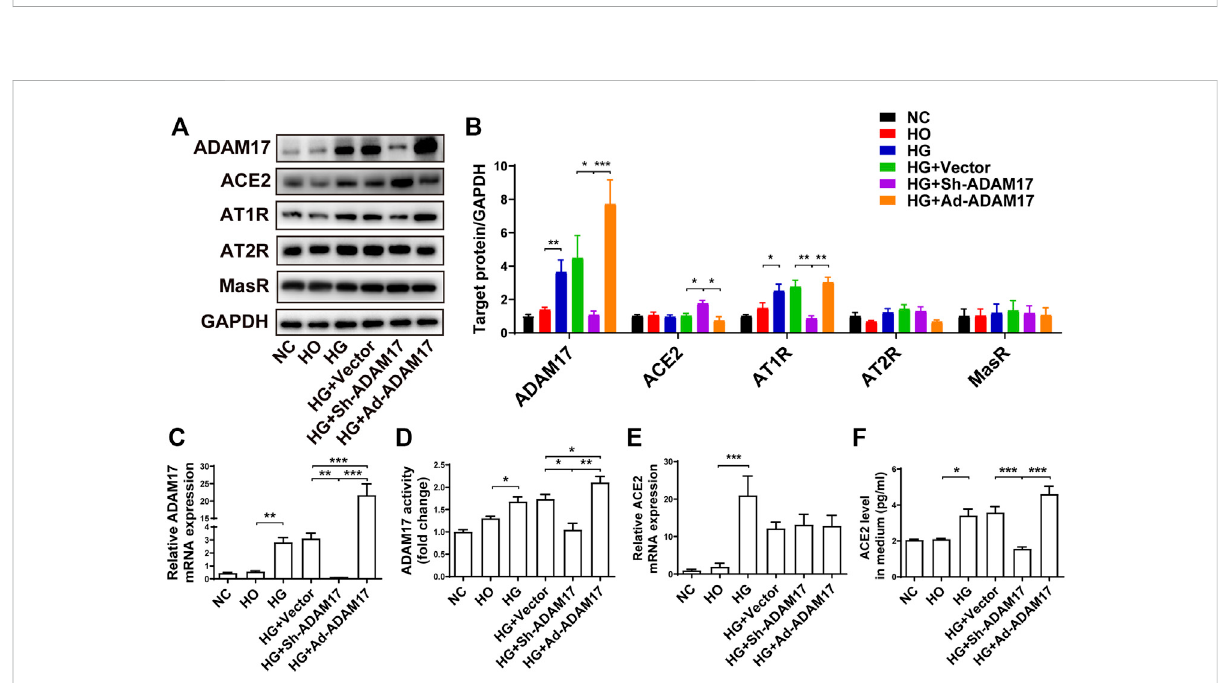
FIGURE 5 Comparison of ADAM17, ACE2, AT1R, AT2R and MasR expression in 6 groups of primary cardio fi broblasts. (A) Representative Western blot images of ADAM17, ACE2, AT1R, AT2R, and MasR in 6 groups of cardio fi broblasts. (B) Quanti fi cation of protein expression of ADAM17, ACE2, AT1R, AT2R, and MasR in 6 groups of cardio fi broblasts. (C) Quanti fi cation of mRNA level of ADAM17 in 6 groups of cardio fi broblasts. (D) Quanti fi cation of ADAM17 activity in 6 groups of cardio fi broblasts. (E) Quanti fi cation of mRNA level of ACE2 in 6 groups of cardio fi broblasts. (F) Quanti fi cation of ACE2 expression inthe medium supernatant of 6groups of cardio fi broblasts. Data wereexpressed as the means ± SEM. * p < 0.05, ** p < 0.01, *** p < 0.001. n = 6 per